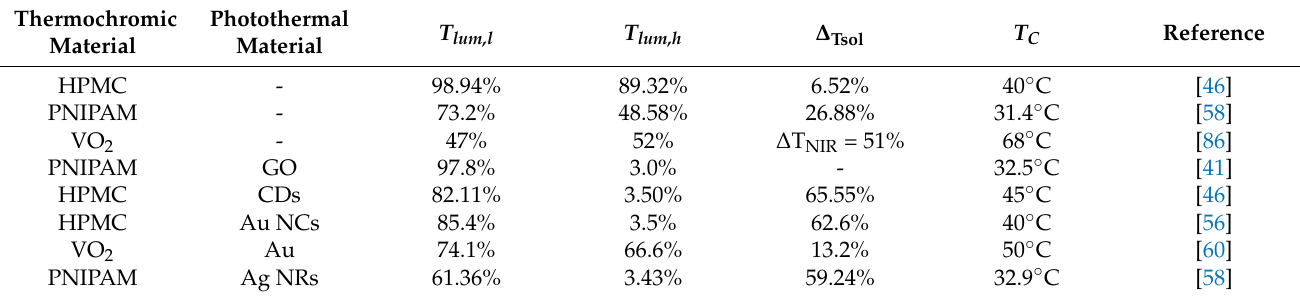
Table 2. Performance comparison of thermochromic smart